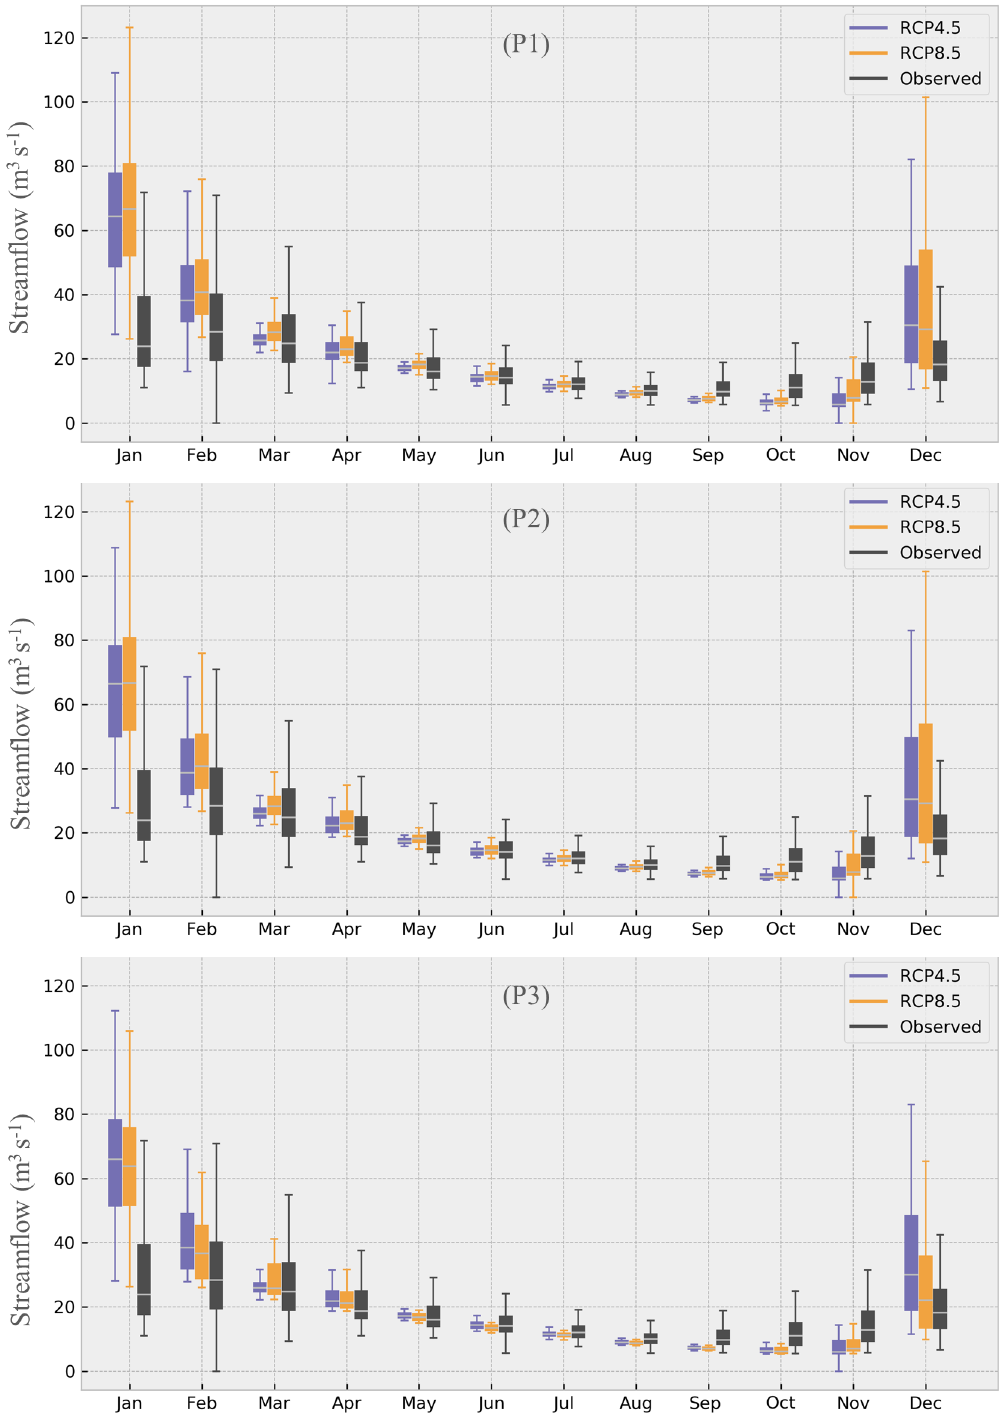
Figure 6. The projected future changes in streamflow under consideration of two scenarios (RCP4.5 and RCP8.5) and three future periods (P1, P2 and P3) compared with the observed period (1991–2008) shown as boxplots, where the boxes show ranges between the 25th and 75th percentiles, and the thick gray line shows the median value. P1 refers to the immediate future (2010–2040), P2 refers to the intermediate future (2041–2070) and P3 refers to the distant future